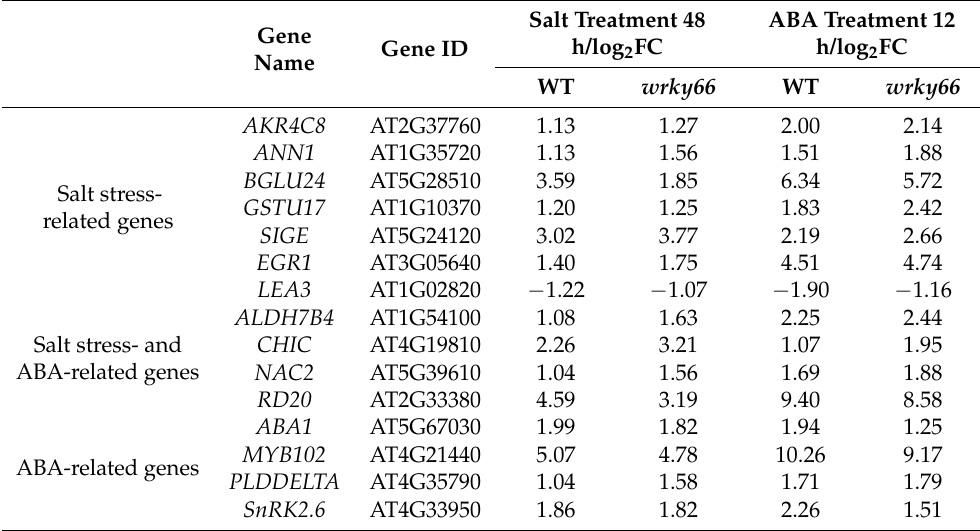
Table 4. Changes in the expression of the salt stress- and ABA- related genes in the WT and wrky66 plants after the NaCl or ABA